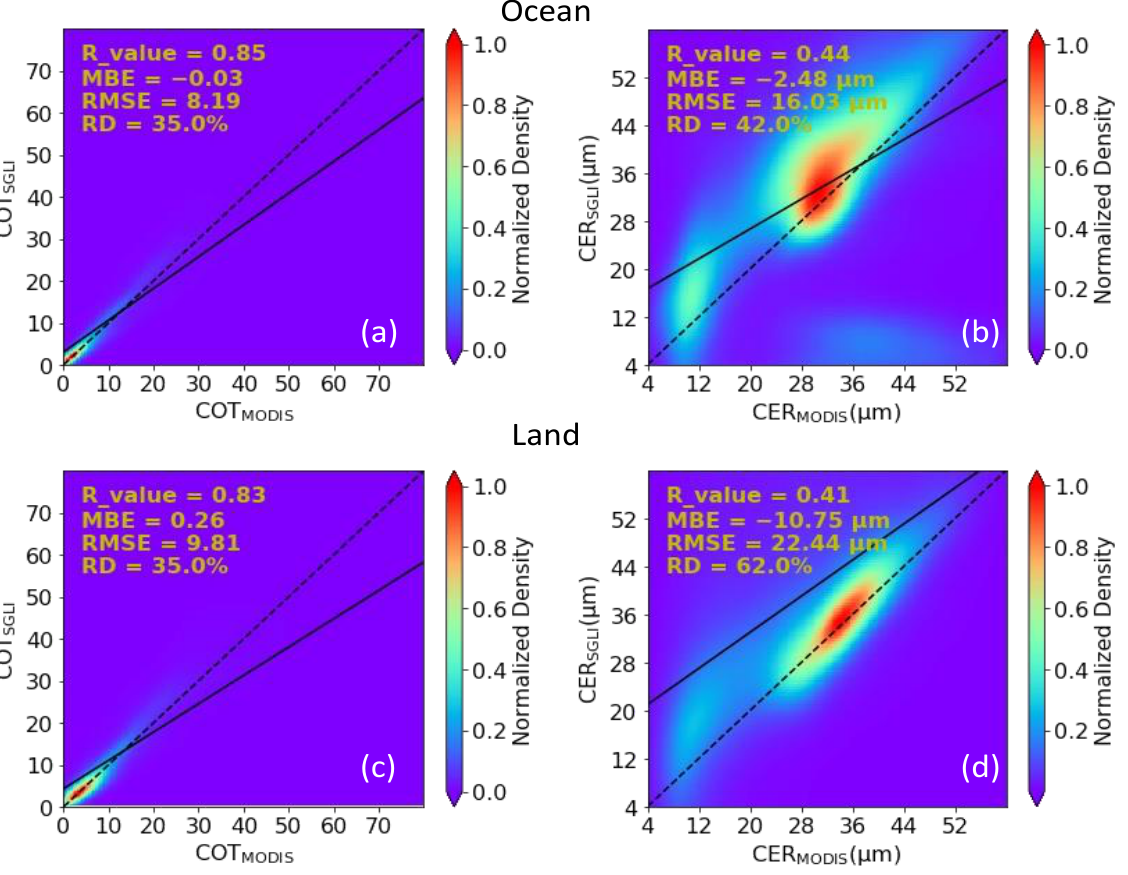
Table 3. Metrics for CER comparisons of ice clouds corresponding to data with MODIS CER ≤ 20 μ m and MODIS CER > 20 μ m .